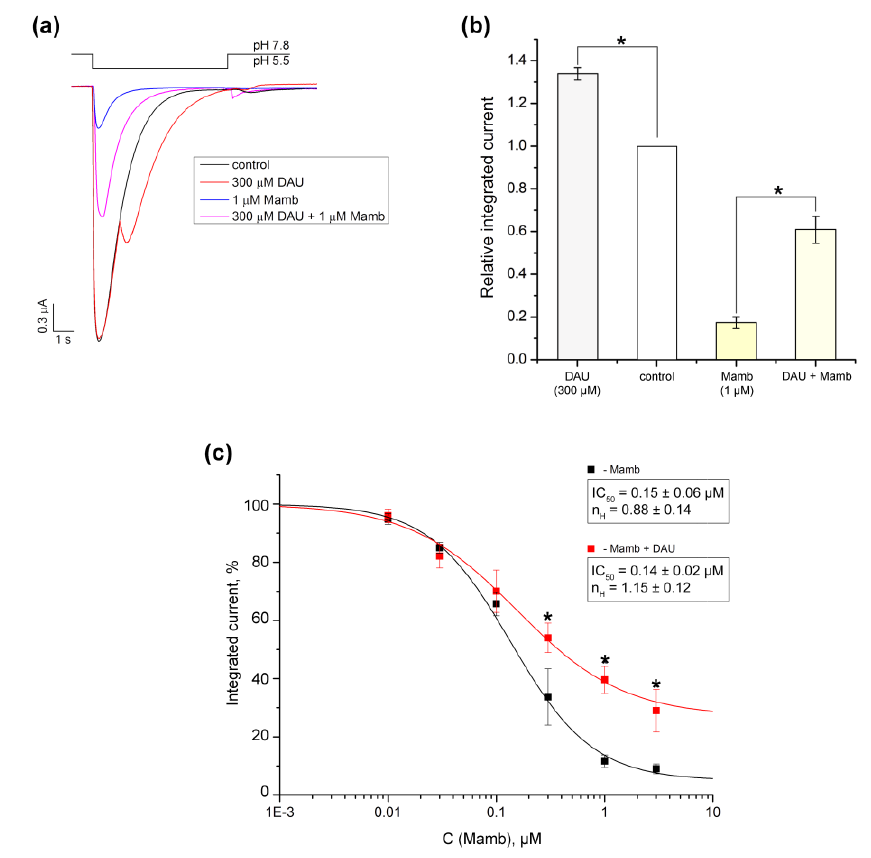
Figure 7. Comparison of the e ff ects that DAU and Mamb-2 have on ASIC1a. ( a ) Representative traces of pH 5.5-evoked currents of ASIC1a alone (black trace) and of ASIC1a with a 15 s pre-incubation of 300 µ M DAU (red trace), 1 µ M mambalgine-2 peptide (Mamb-2) (blue trace), or a mixture of 300 µ M DAU and 1 µ M Mamb-2 (magenta trace). ( b ) Integrated currents measured for ASIC1a (alone and in the presence of each of the following: 300 µ M DAU, 1 µ M Mamb-2, and a mixture of 300 µ M DAU and 1 µ MMamb-2) generated by dropping the pH from 7.8 to 5.5. Data are presented as mean ± SEM; n = 5. * P < 0.05, significantly different from the integrated current at pH 7.8; Kruskal – Wallis ANOVA. ( c ) Dose–response ASIC1a inhibitory curves for Mamb-2 alone (black line) and for Mamb-2 in concurrence with 300 μM DAU (red line). Data were fitted by the logistic equation. The calculated permanent current for Mamb-2 was 5.3 ± 2.3%, and the maximal integrated current increased to 26.7